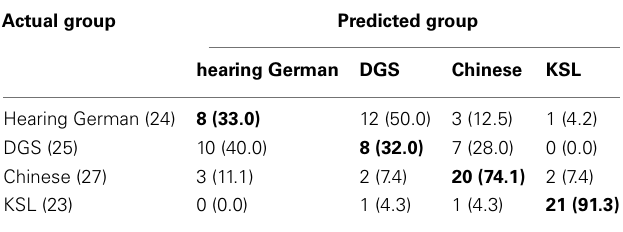
Table 2 | Classification of cases based on the stepwise linear discriminant function analysis using a leaving-one-out cross-validation procedure (see also Figure